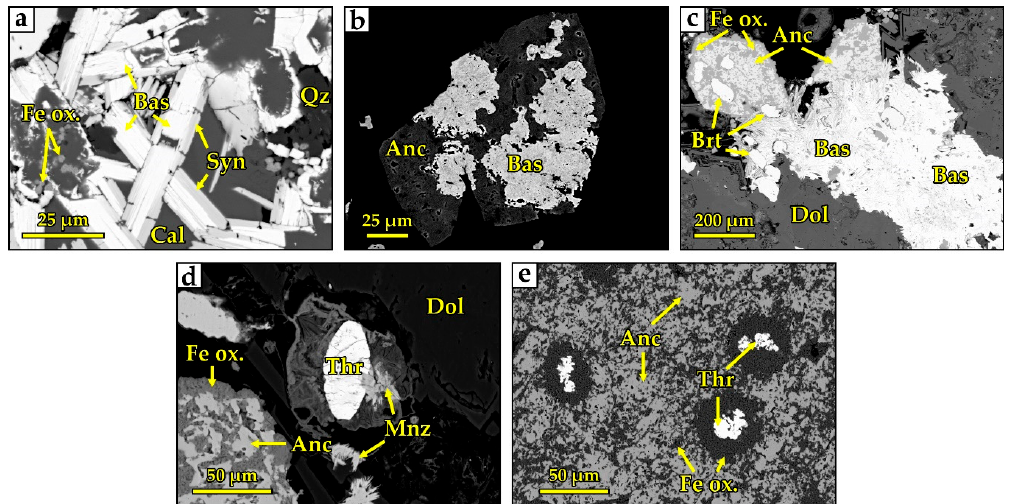
Figure 12. Accessory minerals of ancylite-bearing carbonatites. ( a ) Bastnäsite laths and tabular syntaxial intergrowths of bastnäsite (white) with synchysite (light gray) in late pore-filling quartz and calcite (dark gray). ( b ) Ancylite, pseudomorphically replaced by anhedral aggregates of bastnäsite. ( c ) The cavity, filled by fibroradial bastnäsite aggregates and grains of baryte, ancylite, and iron oxides. ( d ) Monazite in association with thorite. ( e ) HREE-rich thorite inside Fe-oxides. All photomicrographs are BSE images.